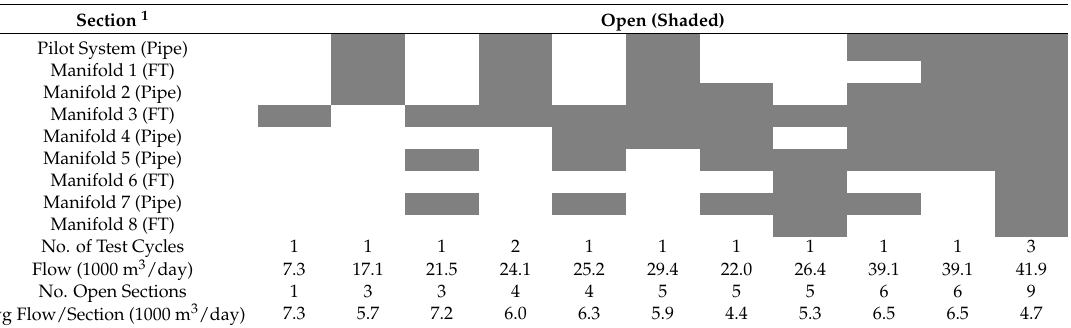
Table 3. Summary of Hydraulic Testing to Date.